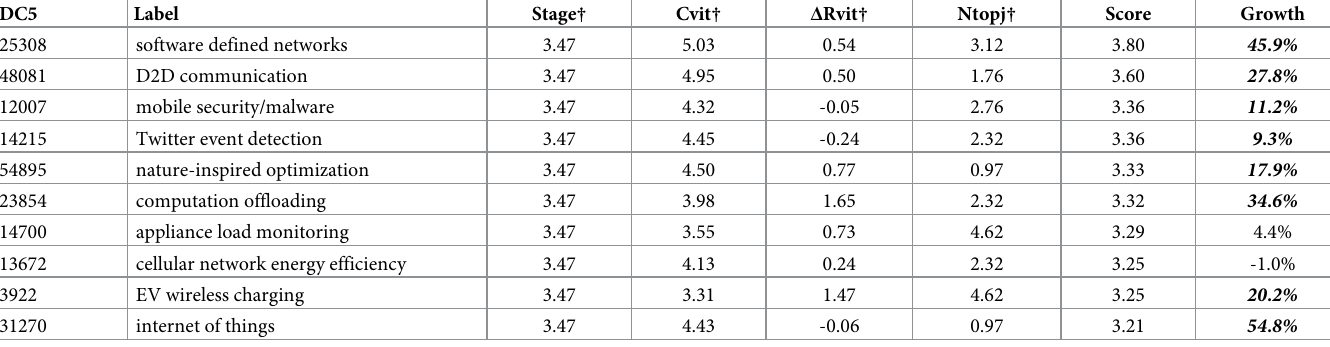
Table 8. Top 10 forecasted DC5 RCs from the Computing Technology field (FY = 2014, TY = 2017, RY = +2).